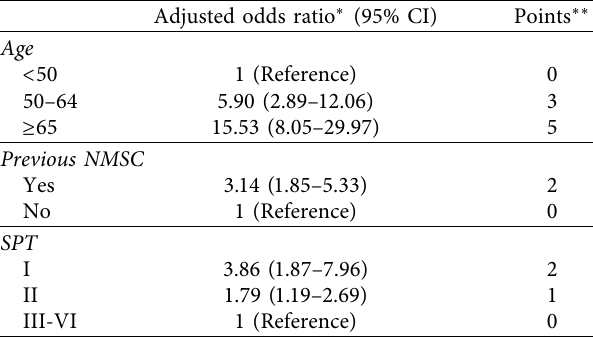
Table 2: Simplified multivariable model and point scoring